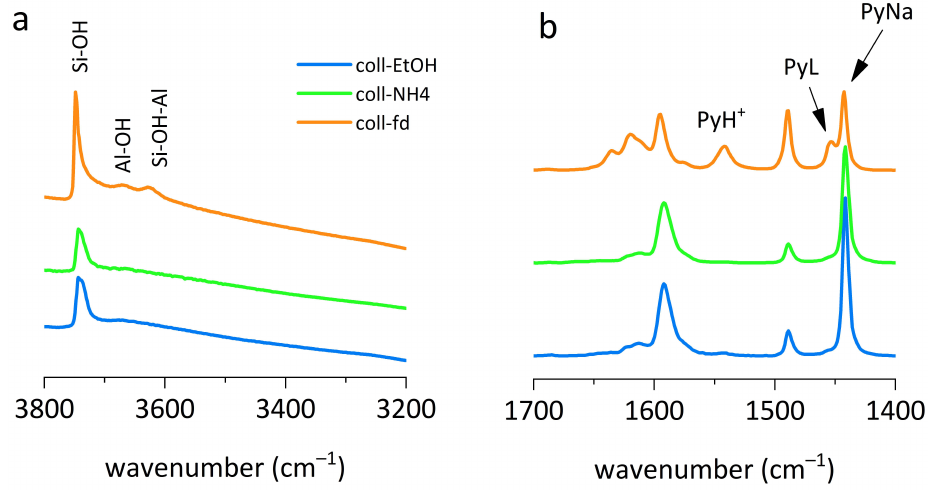
Figure 5. IR spectra of the calcined coll-EtOH, coll-NH 4 , and coll-fd samples in the OH vibrations region ( a ) and after pyridine adsorption ( b